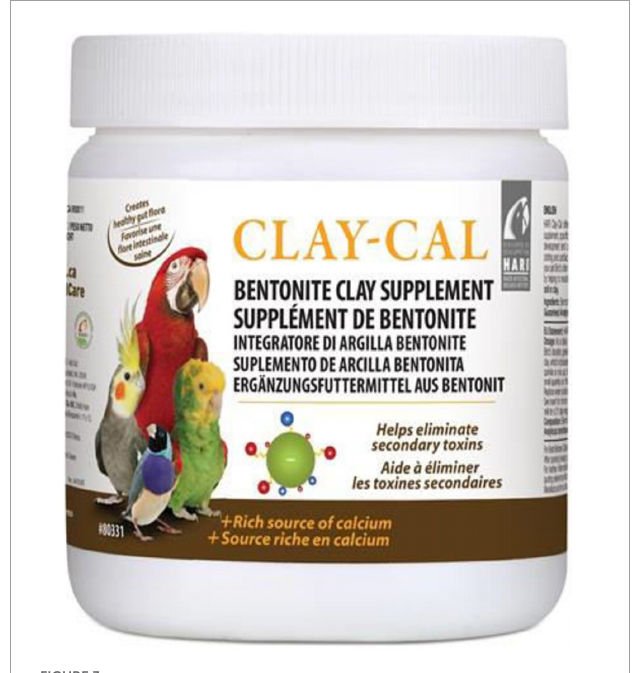
FIGURE3 HARI Clay-Cal, a supplement made available by the distributor: La Voliere Parrot Boutique. It is claimed to be an effective calcium supplement for pet birds whose seed diets are low in calcium. Source: